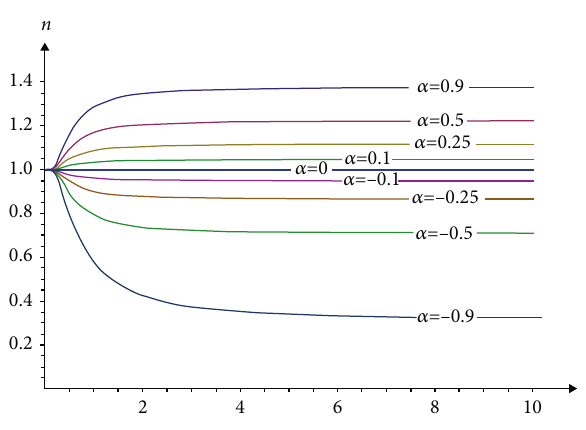
Figure 1: Variation in mean-motion curves.